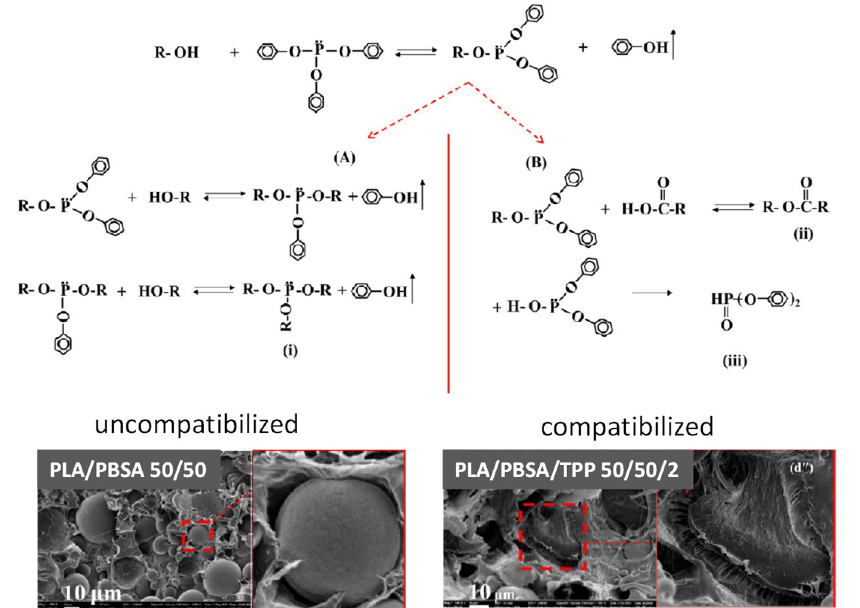
Figure 6. Schematic representation of reaction mechanisms between polyester chains ends and phosphite. SEM pictures (with enlargement of details of interface) for uncompatibilized and com- patibilized blends. Reprinted (adapted) with permission from Ref. [99] Copyright 2013 American Chemical Society.